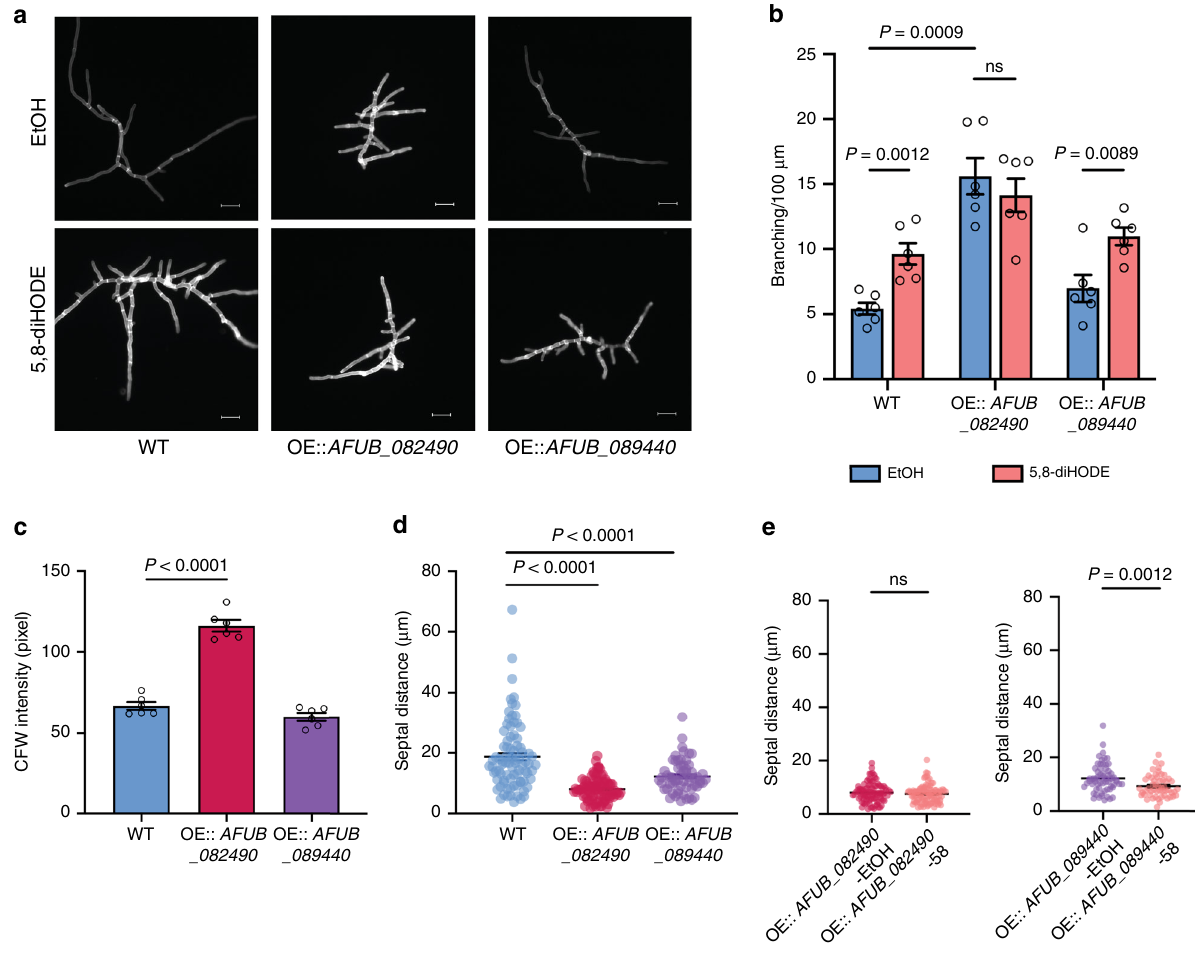
Fig. 7 Overexpression of AFUB_082490 and AFUB_089440 reveals major involvement in 5,8-diHODE-induced branching. a Representative DAPI images of A1160 pyrG + WT, OE:: AFUB_082490 and OE:: AFUB_089440 grown in GMM containing 0.1% EtOH or 5 µ g/mL of 5,8-diHODE on coverslips in 24-well plates. Sixteen-hour-old hyphae were stained with calco fl uor white (CFW), washed in ddH2O, and mounted to slides for fl uorescent microscopy. Six DAPI images were acquired from three wells for each condition in each strain ( n = 6). Images are representative of six microscopic images acquired for each condition. Scale bars represent 20 µ m. b Branching quanti fi cation of OE:: AFUB_082490 and OE:: AFUB_089440 and the A1160 pyrG + WT control ( n = 6) in the experiment conducted in ( a ). Six hyphae from the six DAPI images were analyzed for branching for each condition in each strain. c Quanti fi cation of CFW signals ( n = 6) of hyphae grown in GMM + 0.1% EtOH from images acquired in ( a ). Six hyphae in the six DAPI images were analyzed, where hyphae in each DAPI image were selected through the thresholding function in FIJI, and the mean fl uorescence intensity of each threshold area was measured. d Quanti fi cation of distances between adjacent septa in hyphae grown in GMM + 0.1% EtOH from experiments conducted and imaged acquired in ( a ). Sample sizes representing the number of septal distances counted for each strain are: n = 85 for WT, n = 90 for OE:: AFUB_082490 , and n = 61 for OE:: AFUB_089440 . e Quanti fi cation of septal distances in OE:: AFUB_082490 and OE:: AFUB_089440 hyphae grown in GMM + 0.1% EtOH (OE-EtOH) and